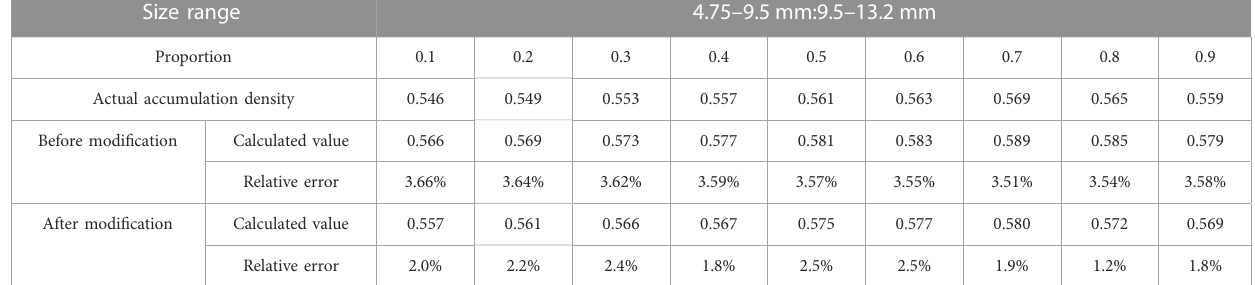
TABLE 3 Differences in packing density.